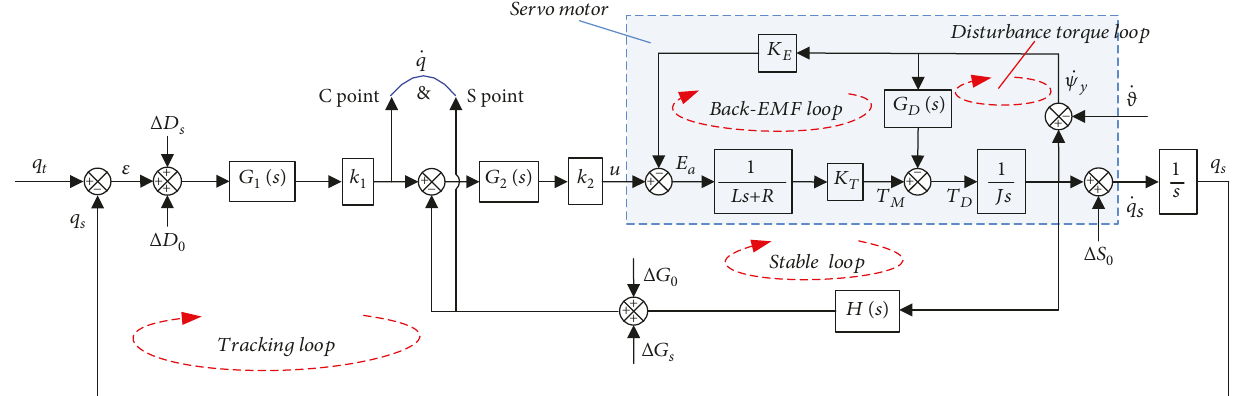
Figure 2: Schematic diagram of the platform seeker tracking control